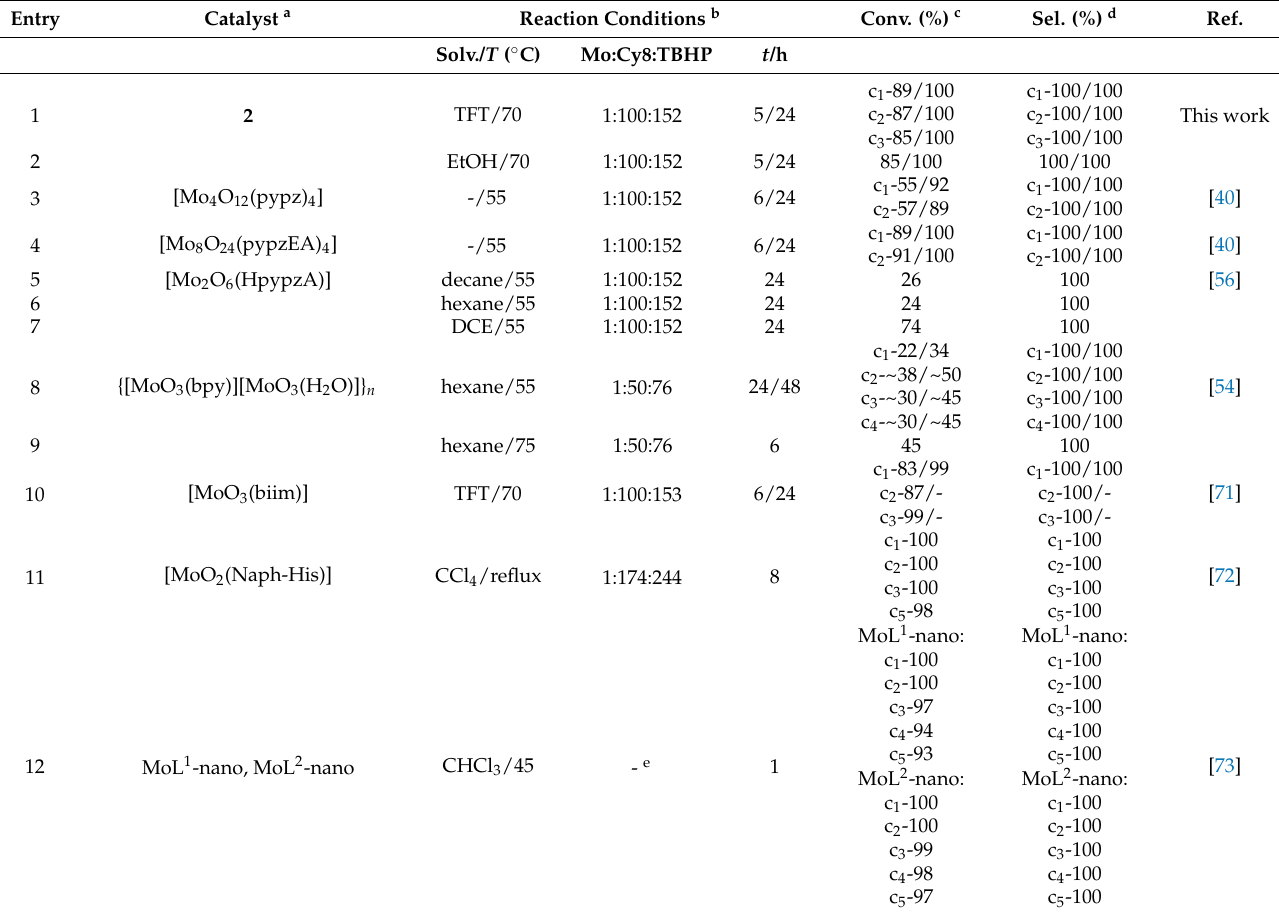
Table 1. Catalytic results for 2 and literature data for bulk heterogeneous hybrid Mo catalysts, tested for cis -cyclooctene (Cy8) epoxidation with tert -butyl hydroperoxide